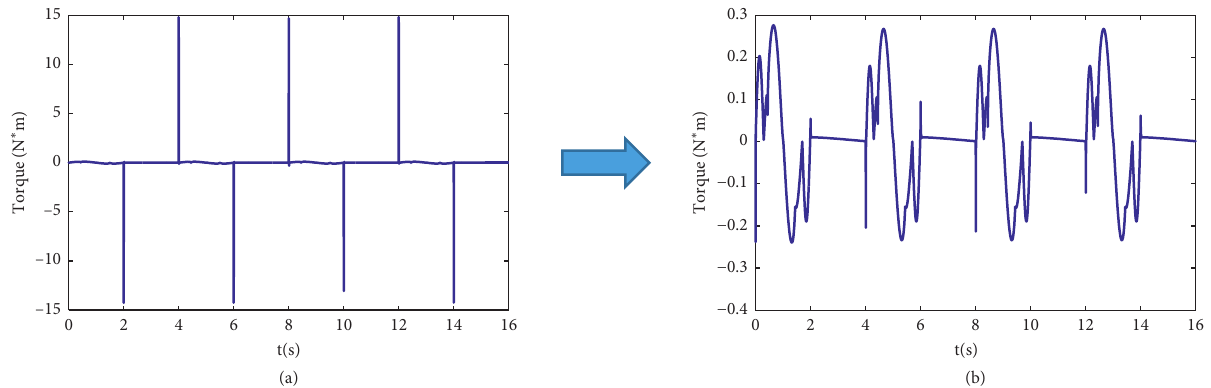
Figure 13: The acceleration curve in the x -direction. (a) Unmodified curve. (b) Modified curve.